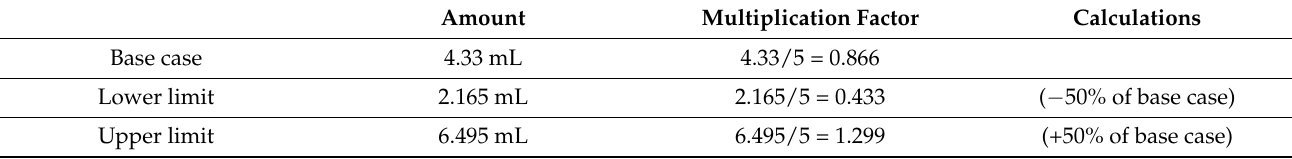
Table A7. Sensitivity Analysis for RIG. Table A8. Total number of visits.